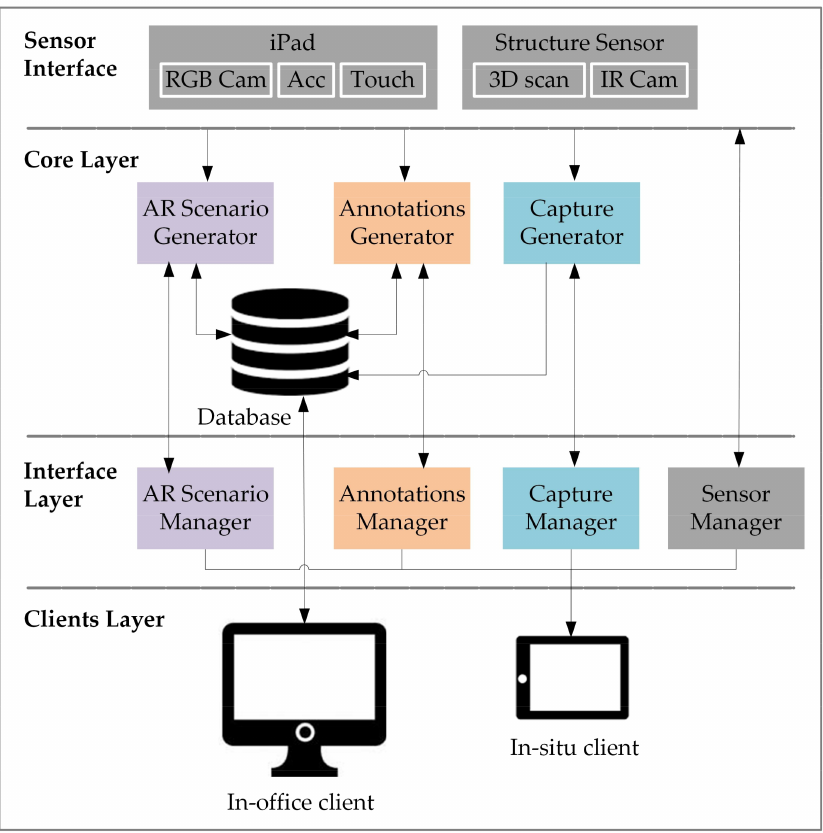
Figure 3. Software architecture in SIRAE, where the sensor interface and the three software layers are